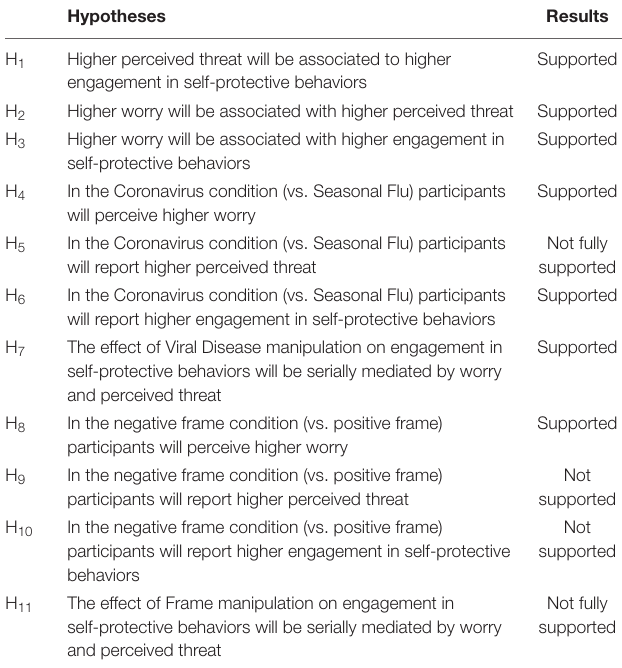
TABLE 6 | Summary of research hypotheses and